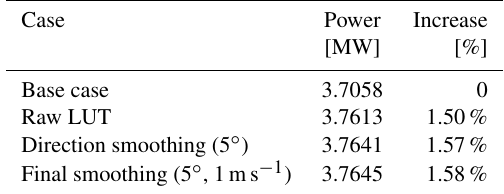
Table 1. Mean power values from Fig.